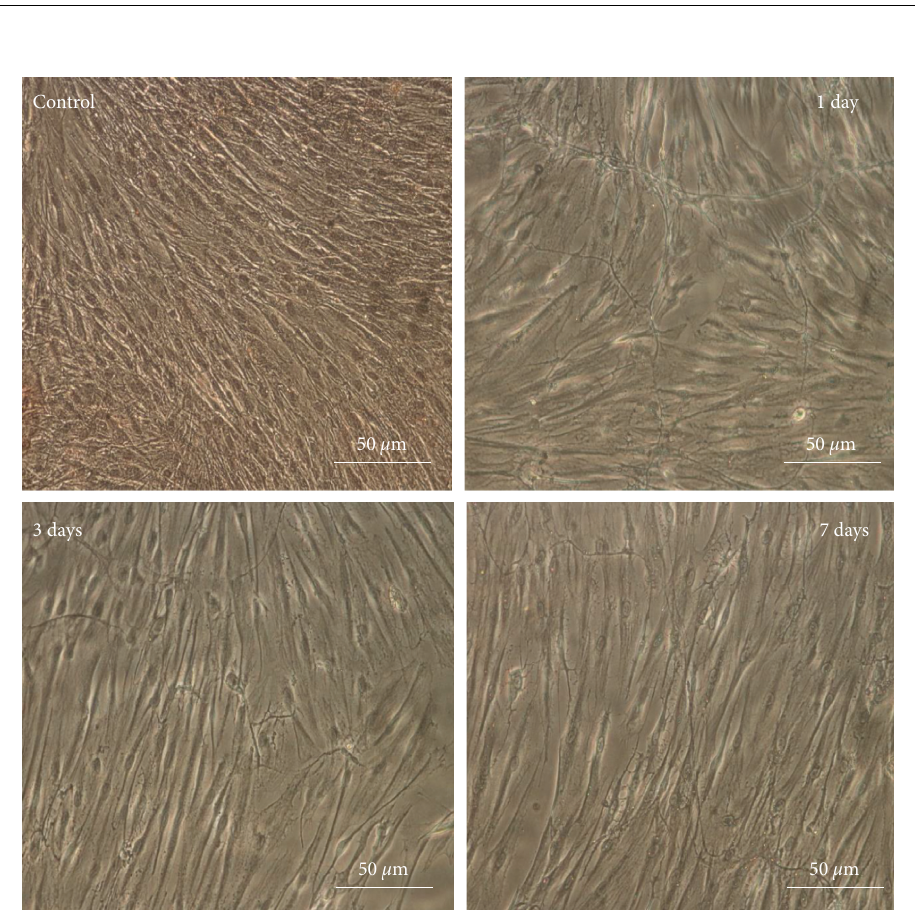
Figure 8: Optical images of the MG-63 cells cultured on the PEDOT-HNT/CS-MHA bilayer-coated implant.